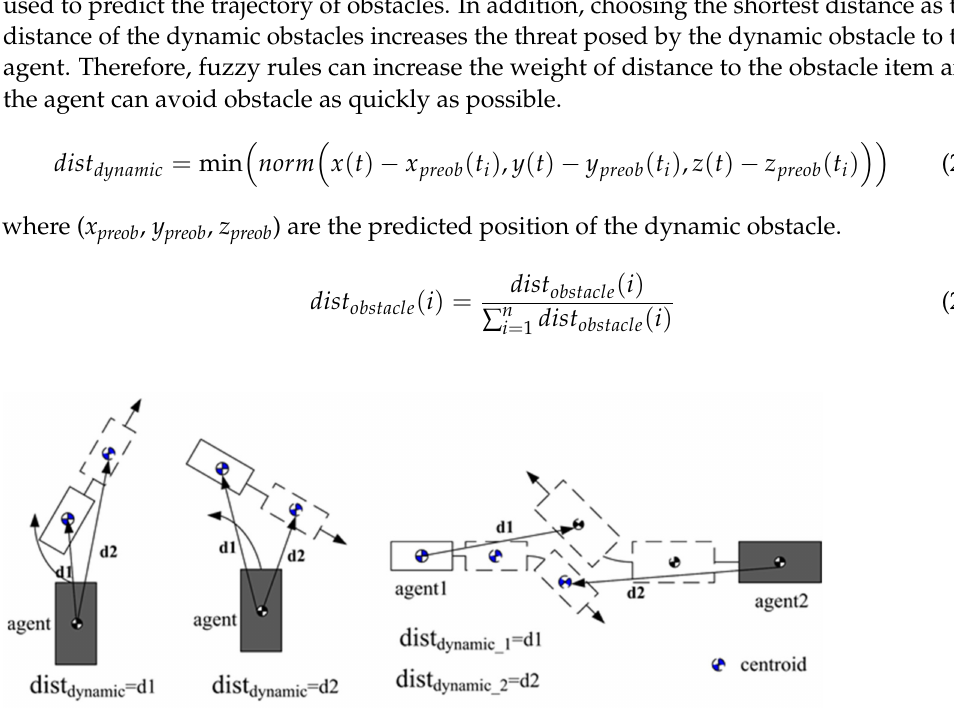
Figure 7. Perception prediction planning